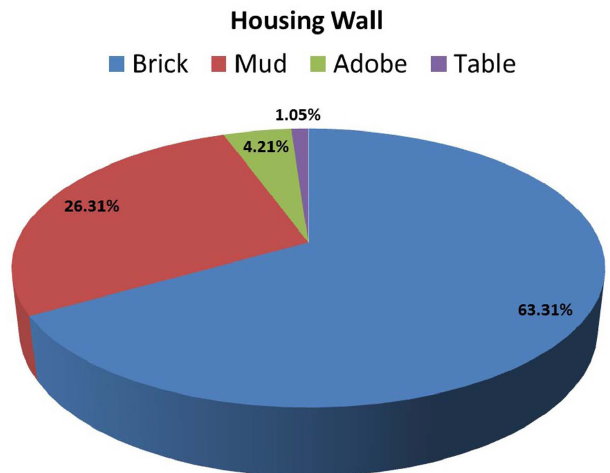
Fig. 3 - Welfare situation of children with congenital cardiopathies hospitalized at HUUFMA in São Luís (2011 and first semester 2012).